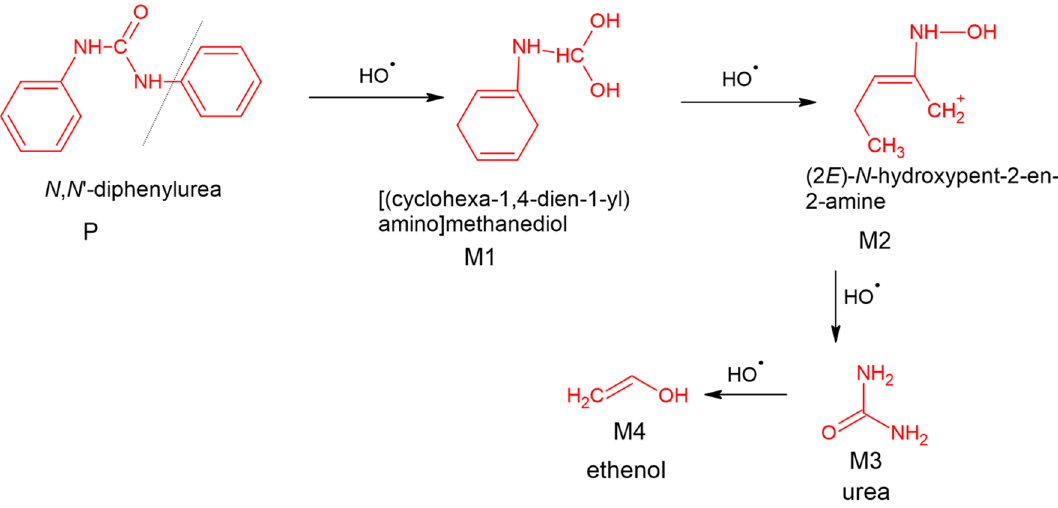
Figure 5. Mechanism of degradation of Diphenyl